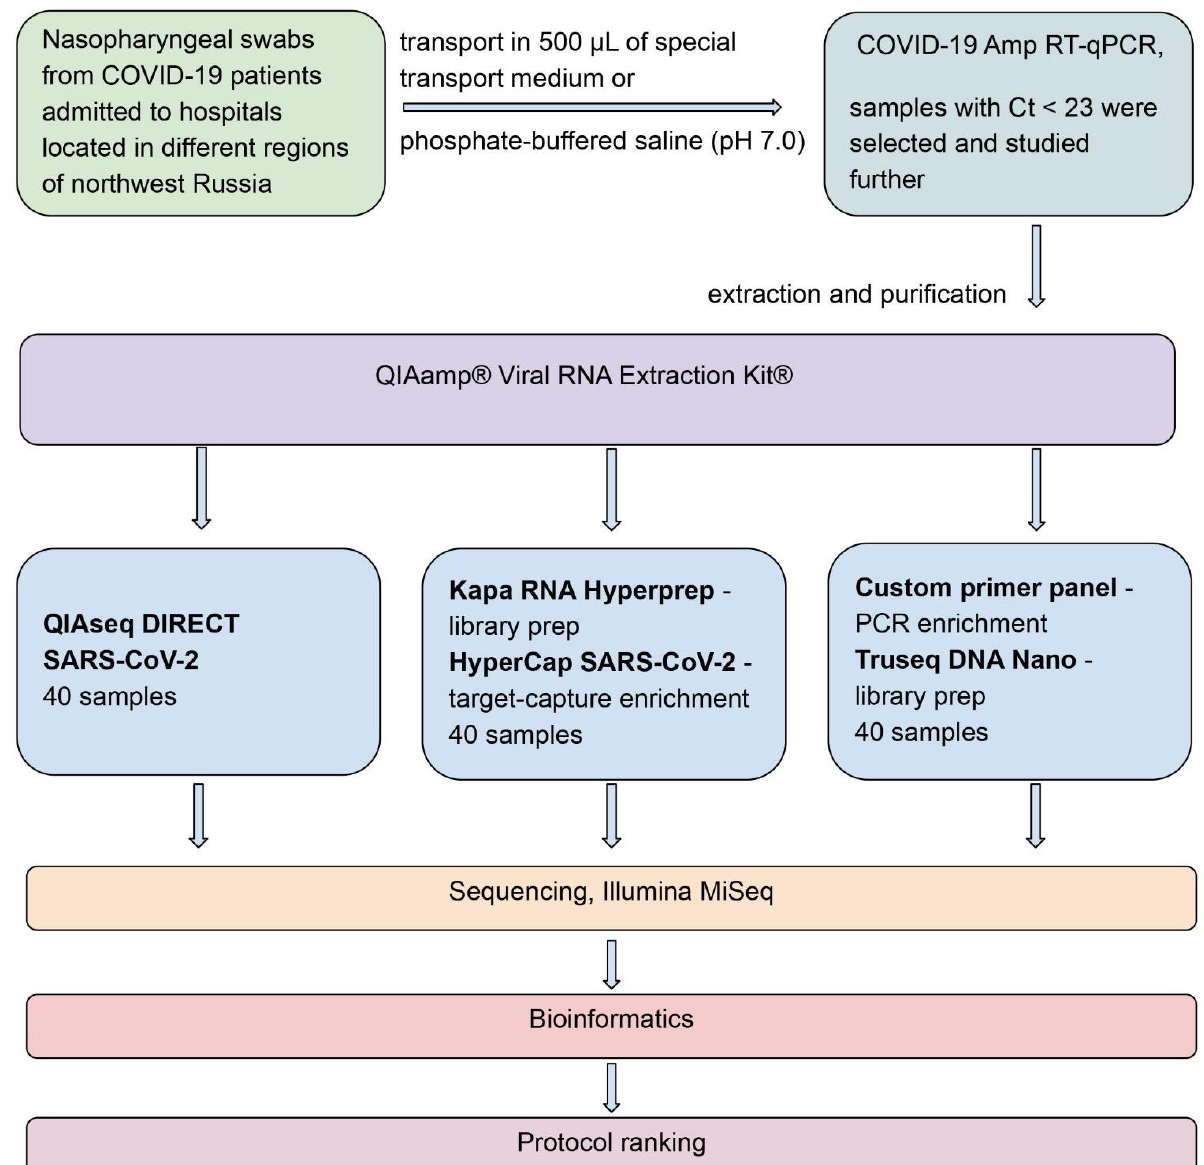
Figure 1. General design and experimental layout of the study. Patient nasal swabs ( N = 40) were used to obtain RNA, which was then used to prepare WGS libraries according to three different protocols. After library preparation, each protocol’s samples were sequenced by Illumina MiSeq, followed by the bioinformatic analysis of the data.